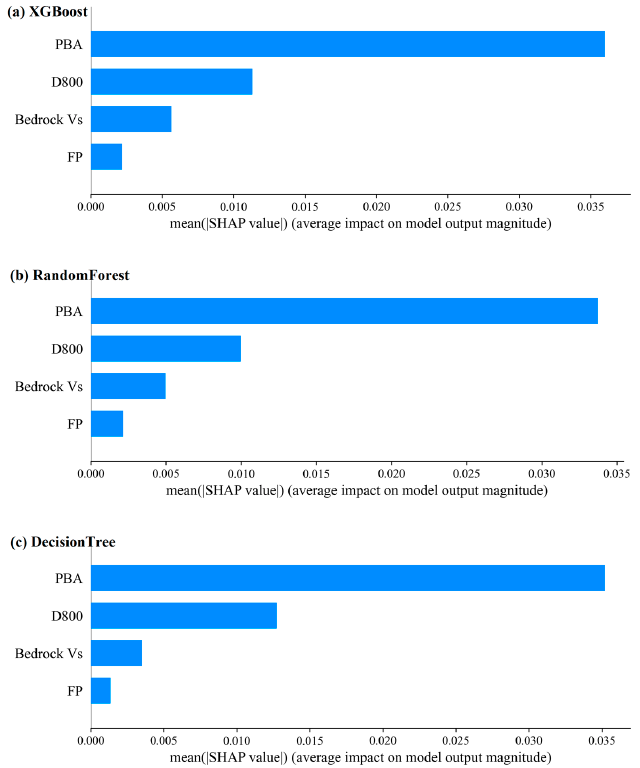
Figure 13. Global importance of all input features for ( a ) XGBoost, ( b ) Random Forest, ( c ) Decision Tree.